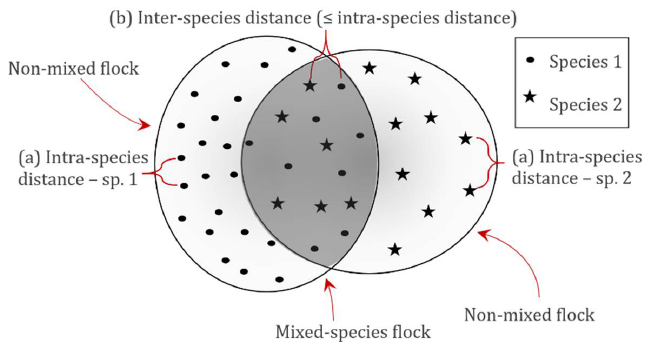
Figure 3. Method for differentiating between mixed and non-mixed flocks of roosting waterbirds. First, (a) intra-species distances were measured for each species. Inter-species distances (b) were then compared with the determined intra-species distances. If equal to or below the 95th percentile of these intra-species distances, the individual was considered part of a mixed-species flock. Intra-species distances were measured by self-joining each species-specific layer, and inter-species distances were measured by joining each species layer to all other species layers. Both measures were performed using the “Near” tool in ArcGIS Pro. Subsequently, by calculating the 95th percentiles of the intra-species-specific distances, individuals were pooled into either mixed or non-mixed flocks (Table S1). The intra-species 95th percentile distances for all species pooled were 2.4 m (field day 1) and 3.7 m (field day 2). Differences between mixed and non-mixed flocks were tested using the Wilcoxon test for matched pairs [36], and further differences in variance were tested using Levene’s test for equality of variances, which was performed for each species and generally for all individuals pooled [37]. 2.4.4. Inter-Species Interactions Fine-scale spatial distributions on high-tide roosting grounds were assessed to reveal possible specific species–species interactions, observable as alterations in species-specific densities. To this end, we investigated two measures of inter-species influences: (a) dis- tance to the nearest individual of another species; and (b) the number of individuals of all other species within a circular zone of 10 m around each individual. The 10 m circular zones were for both measures; in this study, this was assumed to be the maximum dis- tance for detectable inter-species influences. Calculations for the nearest other species (nearest neighbor analysis) were performed in ArcGIS Pro, using the “Near” tool and total number within the circular zone of 10 m, calculated by setting the option “count” in the “Spatial Join” tool. To assess the best fit, quadratic polynomial regressions for densities against the two interaction variables were performed for each species. Data were grouped in species-specific percentile intervals of even spreading according to number of individ- uals, with a minimum of 5 observations in each interval, and a maximum of 20 intervals, with both parameters based on either the distance to the nearest other species (a) or indi- viduals inside the circular zone (b). For each percentile data grouping, 95% CIs were cal- culated by bias-corrected and accelerated (BCa) bootstrapping with 10,000 replications, using the “boot” package in R [32]. Additionally, for each species, the determination co- efficient ( R 2 ) and Spearman’s rank correlation coefficient ( R s ) were calculated [38]. 2.4.5. Habitat Selection and Density The habitat selection of the roosting waterbirds on the roost site was assessed to de- termine the influence of specific habitat types on bird densities. Classifications of habitat types and distribution on the roost site were conducted for the combined UAS flights for each of the two field days. This analysis was performed in Trimble eCognition Developer (version 9.1, Trimble, Inc., Sunnyvale, CA, USA) software (Figure S2), by multiresolution